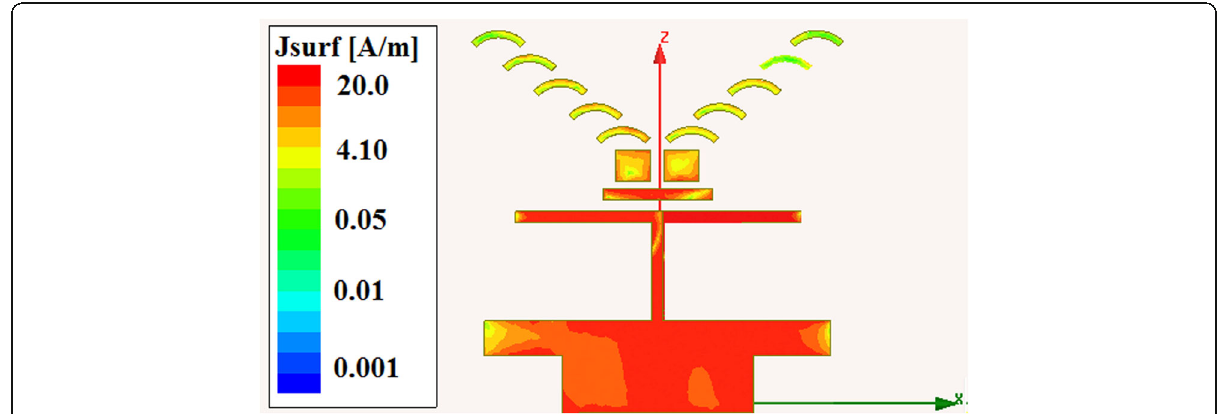
Fig. 20 Surface current distribution at 14 GHz